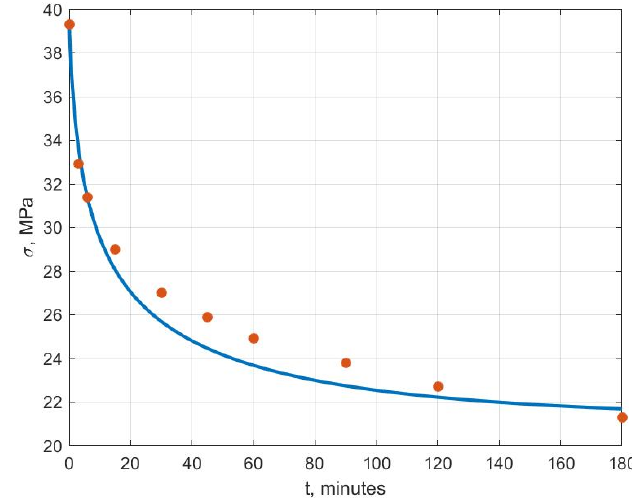
Figure 8. Stress relaxation curve at 𝑇 = 40 °C .